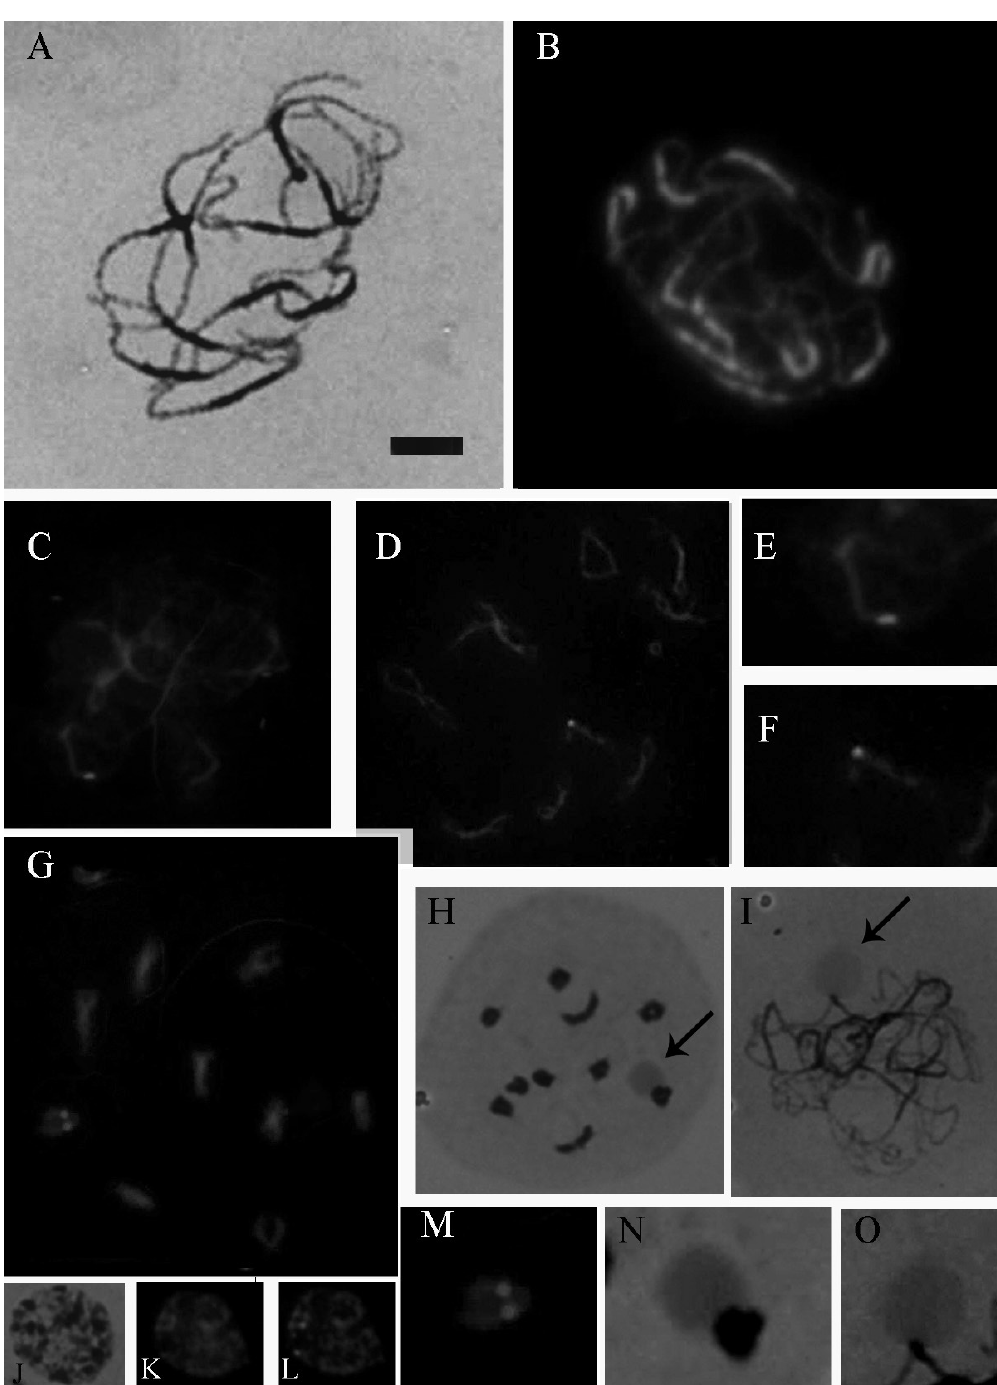
Fig. 3 – (A) Pachytene C-banded, (B) Pachytene DAPI stained showing positive marks around the centromers, (C) Pachytene stained with CMA 3 , (D) Diplotene stained with CMA 3 , (E) Detail of the positive CMA 3 mark onto pachytenic chromosome, (F) Detail of the CMA 3 positive mark onto diplotenic chromosome, (G) Diakinesis stained with CMA 3 , (H) Diakinesis with one chromosome pair attached to the nucleolus (arrow), (I) Pachytene with one chromosome pair attached to the nucleolus (arrow), (J, K, L) Interphasic nucleus stained with Giemsa, DAPI and CMA 3 (see two positive marks), (M) Detail of CMA 3 positive marks onto the chromosomes at diakinesis, (N, O) Details of nucleolus attached to one chromosome pair during the diakinesis and pachytene, respectively. Barr = 5 μ